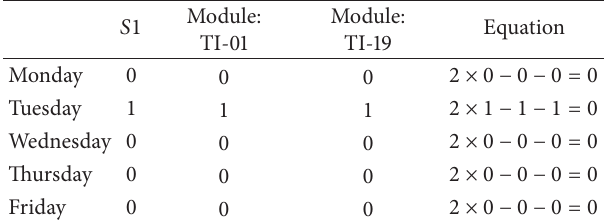
Table 4: 𝑆1 : variable equals 1.